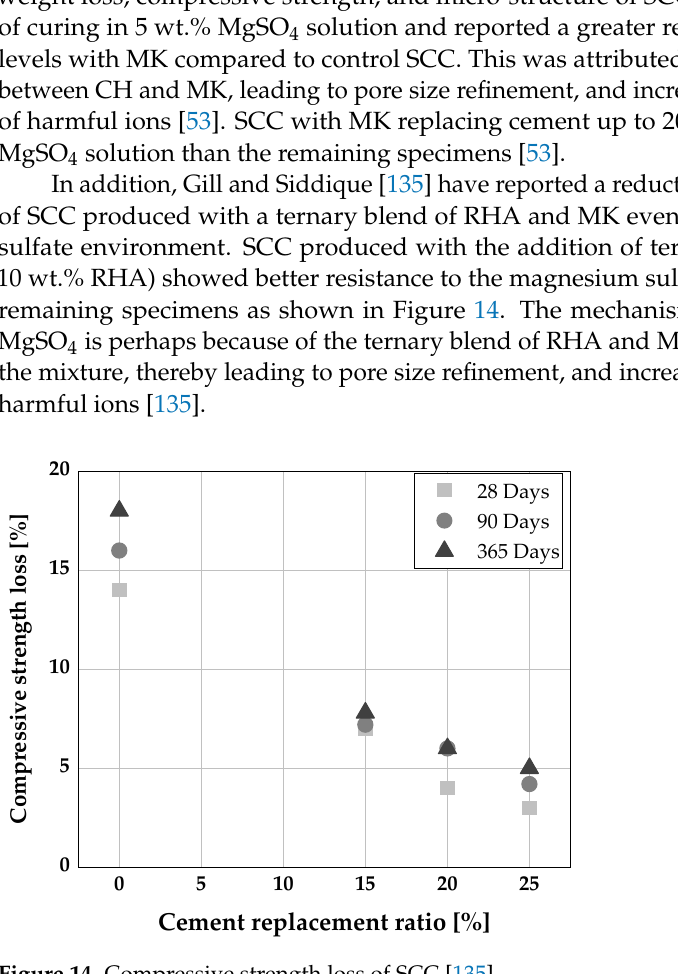
Figure 13. Rapid chloride penetration of SCC produced with RHA and/or MK [110].